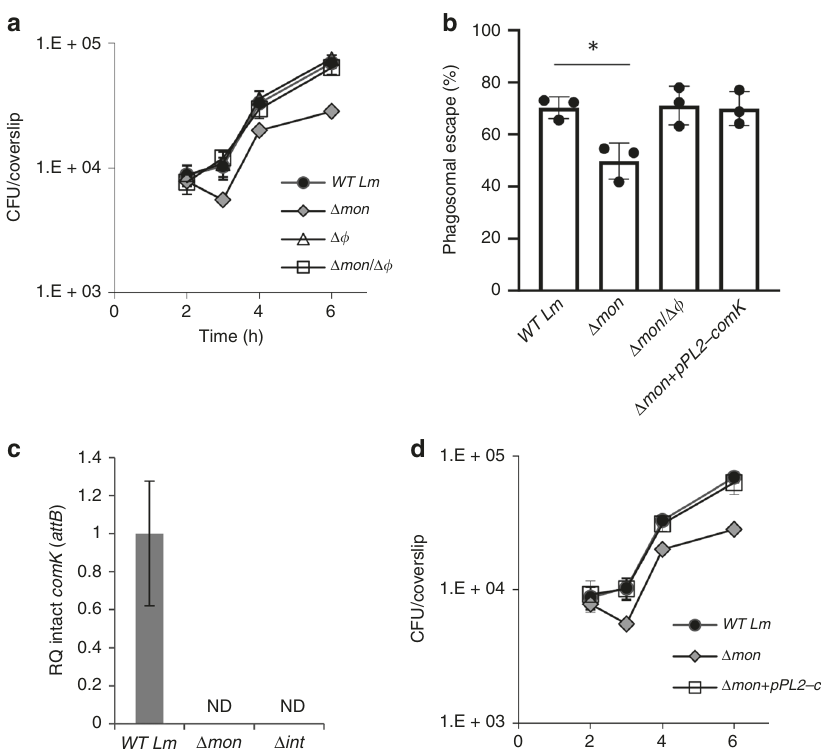
Fig. 2 The monocin element affects ϕ 10403S excision within macrophage cells. a Intracellular growth analysis of WT Lm and mutants lacking each of the phage elements, Δ mon and Δ ϕ (monocin cluster and ϕ 10403S, respectively), and a double mutant lacking both phage elements Δ mon/ Δ ϕ , in BMDM cells. Growth curves represent one biological replicate, more independent experiments are shown in the source fi le. Error bars represent standard deviation of triplicate samples, and are hidden by the symbols. b A bacterial phagosomal escape assay. Percentage of bacteria that escaped the macrophage phagosomes at 2.5 h post infection, as determined by a microscope fl uorescence assay. Macrophages were infected with WT Lm , Δ mon and Δ mon/ Δϕ bacteria, as well as with a Δ mon mutant that was complemented with an intact comK gene on the pPL2 plasmid ( Δ mon + pPL2 -comK ). The data is a mean of three independent experiments. The error bar represent standard deviation. Asterisk (*) indicates statistical signi fi cance of p = 0.01 calculated using Student's t -test. c qRT-PCR analysis of intact comK gene (representing ϕ 10403S attB site) in WT Lm and indicated mutants grown intracellularly in BMDM cells (6 h post infection). Presented as relative quantity (RQ), relative to the levels in WT bacteria. The data represent three independent experiments. Error bars indicate a 95% con fi dence interval. d Intracellular growth analysis of WT Lm , Δ mon and the Δ mon mutant complemented with an intact comK gene with its native promoter ( Δ mon + pPL2 -comK ) in BMDM cells. Growth curves represent one biological replicate, more independent experiments are shown in Supplementary Fig. 2 and in the source data fi le. Error bars represent standard deviation of triplicate samples, and are hidden by the symbols. Source data are provided as a Source Data fi